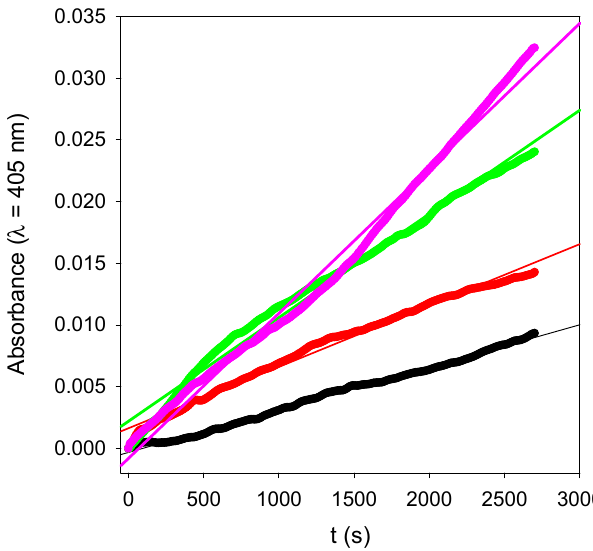
Figure 10. Enzymatic kinetics for (PAH-PDA@ALP) n films put in contact with a 20-fold diluted PNP solution as a function of the number of deposited layer pairs: n = 3 ( __ • __ ), n = 6 ( __ • __ ), n = 12 ( ___ • ___ ), and n = 15 ( __ • __ ). The data points correspond to the experimental data, whereas the solid lines correspond to linear regressions of the data.